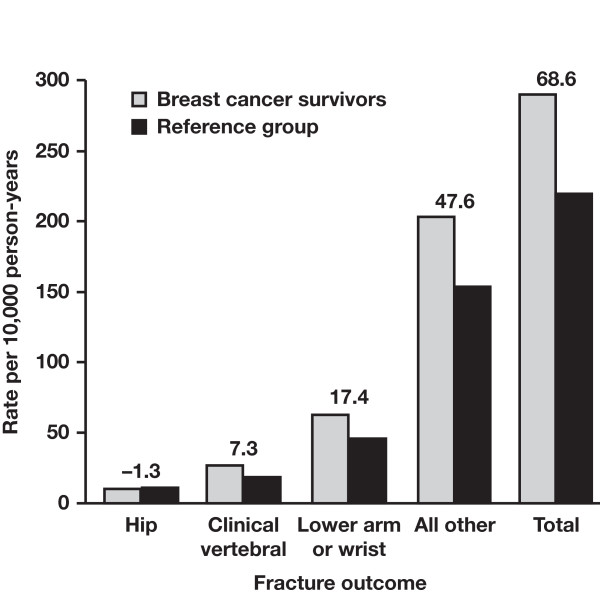
Age-standardized fracture incidence rates. Standardized rates were calculated using the age distribution of the entire study cohort. Excess numbers of fractures per 10,000 person-years are above each set of bars. Reprinted with permission from Chen Z, et al. Arch Intern Med. 2005;165:552-558 [4]. Copyright © 2005, American Medical Association. All rights reserved.